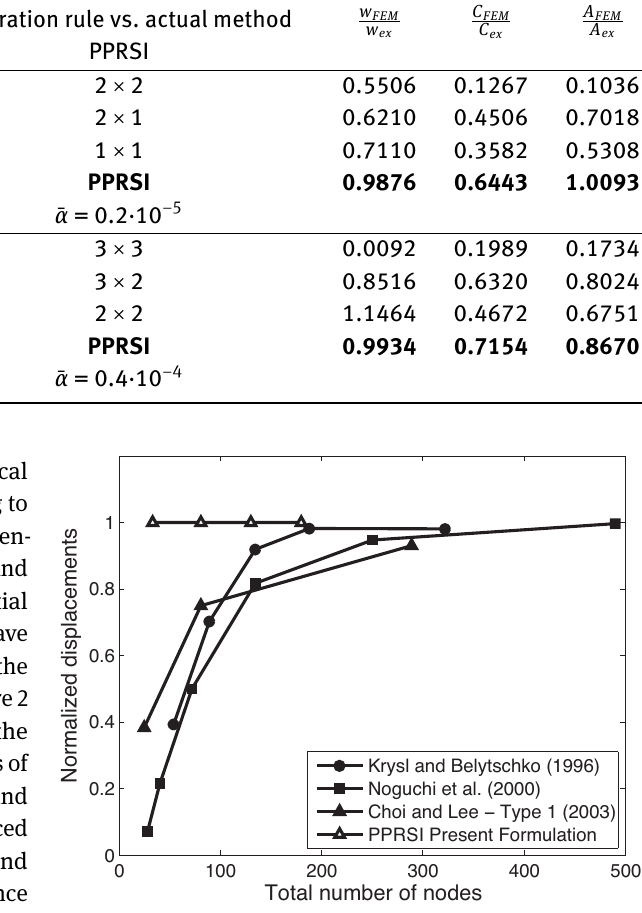
Figure 3: Numerical test example 1: convergence of the displace- ment under the concentrated load in the horizontal cylinder